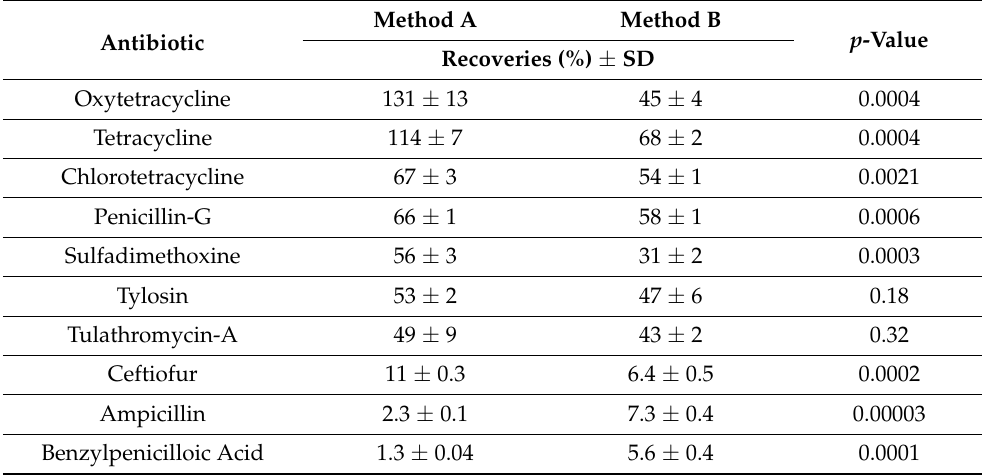
Table 3. Results for optimization experiment that combined extracts for one injection per sample. Method A was compared to Method B as diagrammed in Figure